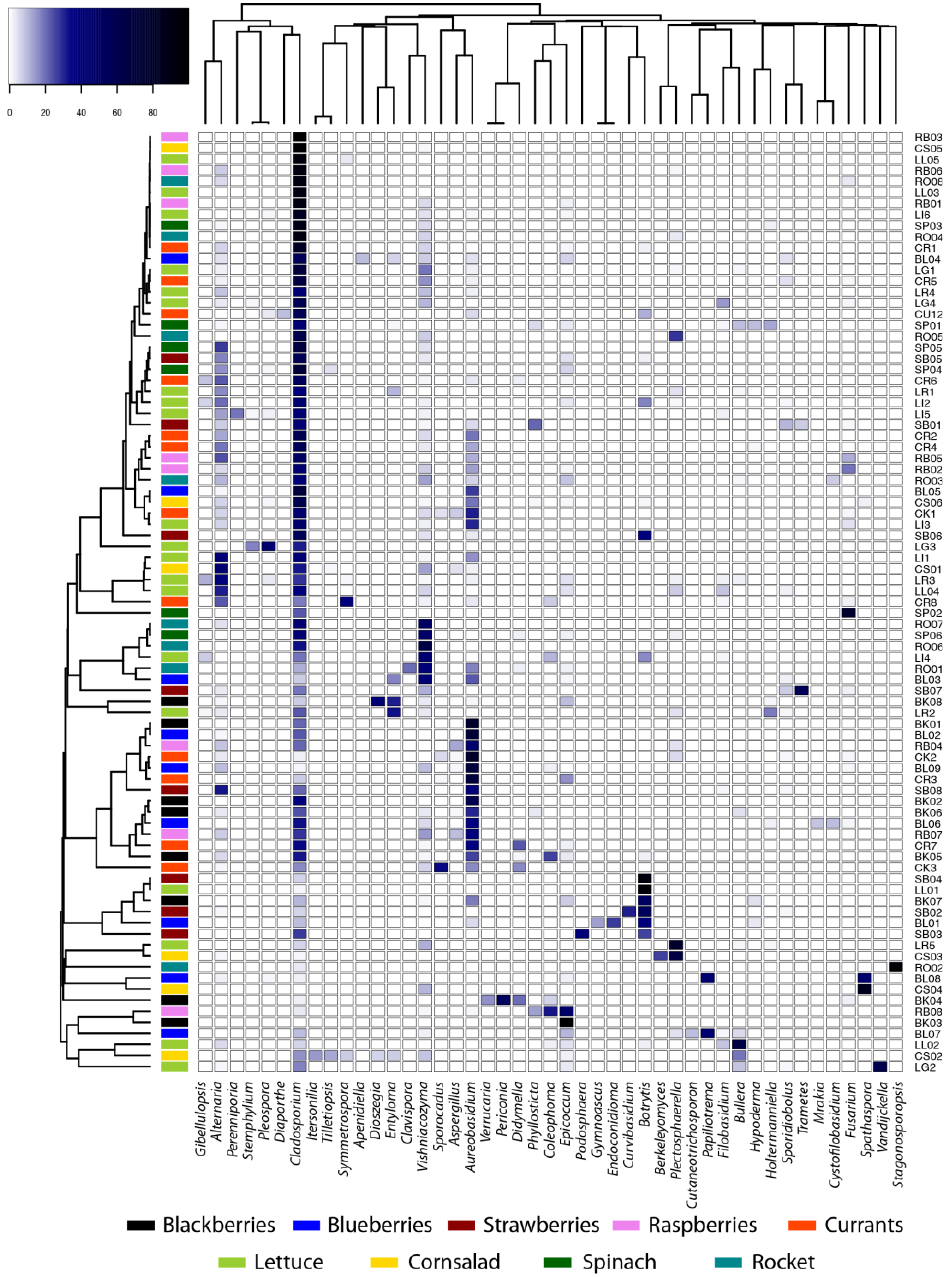
Figure 3. Heatmap of fungal genera composition according to analysis of DNA extracted from fresh tissue samples of leafy vegetables and berry fruits. Only genera with min. 2% occurrences in any samples are listed. Dendrograms are based on occurrence of genera in samples (Bray-Curtis distance, complete clustering).